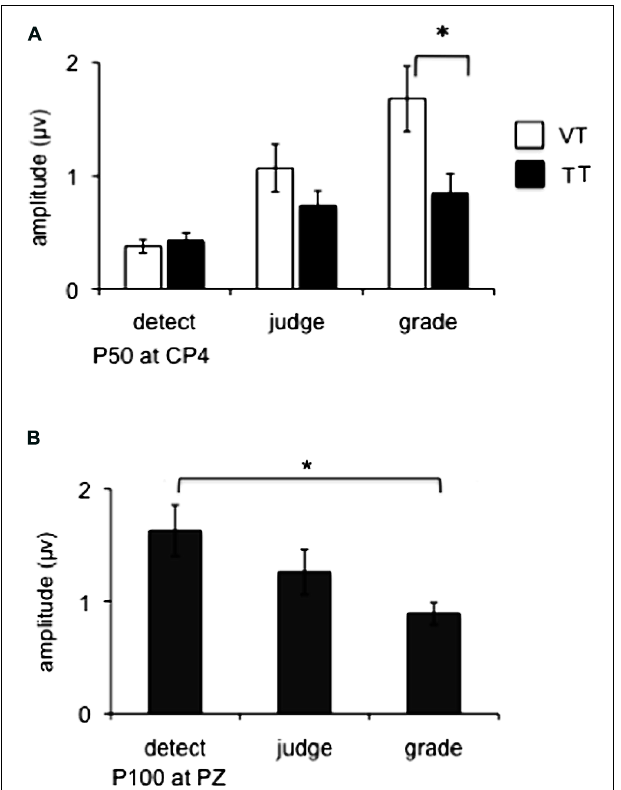
FIGURE 3 | (A) Group means ( n = 10) in Experiment 1 for P50 amplitude measured at CP4.White ars represent group data for the crossmodal visual + tactile task condition (VT), black bars represent group data for the unimodal tactile condition (TT). * Denotes significance ( p < 0.05) between the specific conditions marked by the bracket. (B) Group means ( n = 10) for P100 amplitude measured at PZ. Bars represent group data for the three task conditions collapsed across modality Error bars show SEM. * Denotes significance of the main effect of task ( p < 0.05) encompassed by the